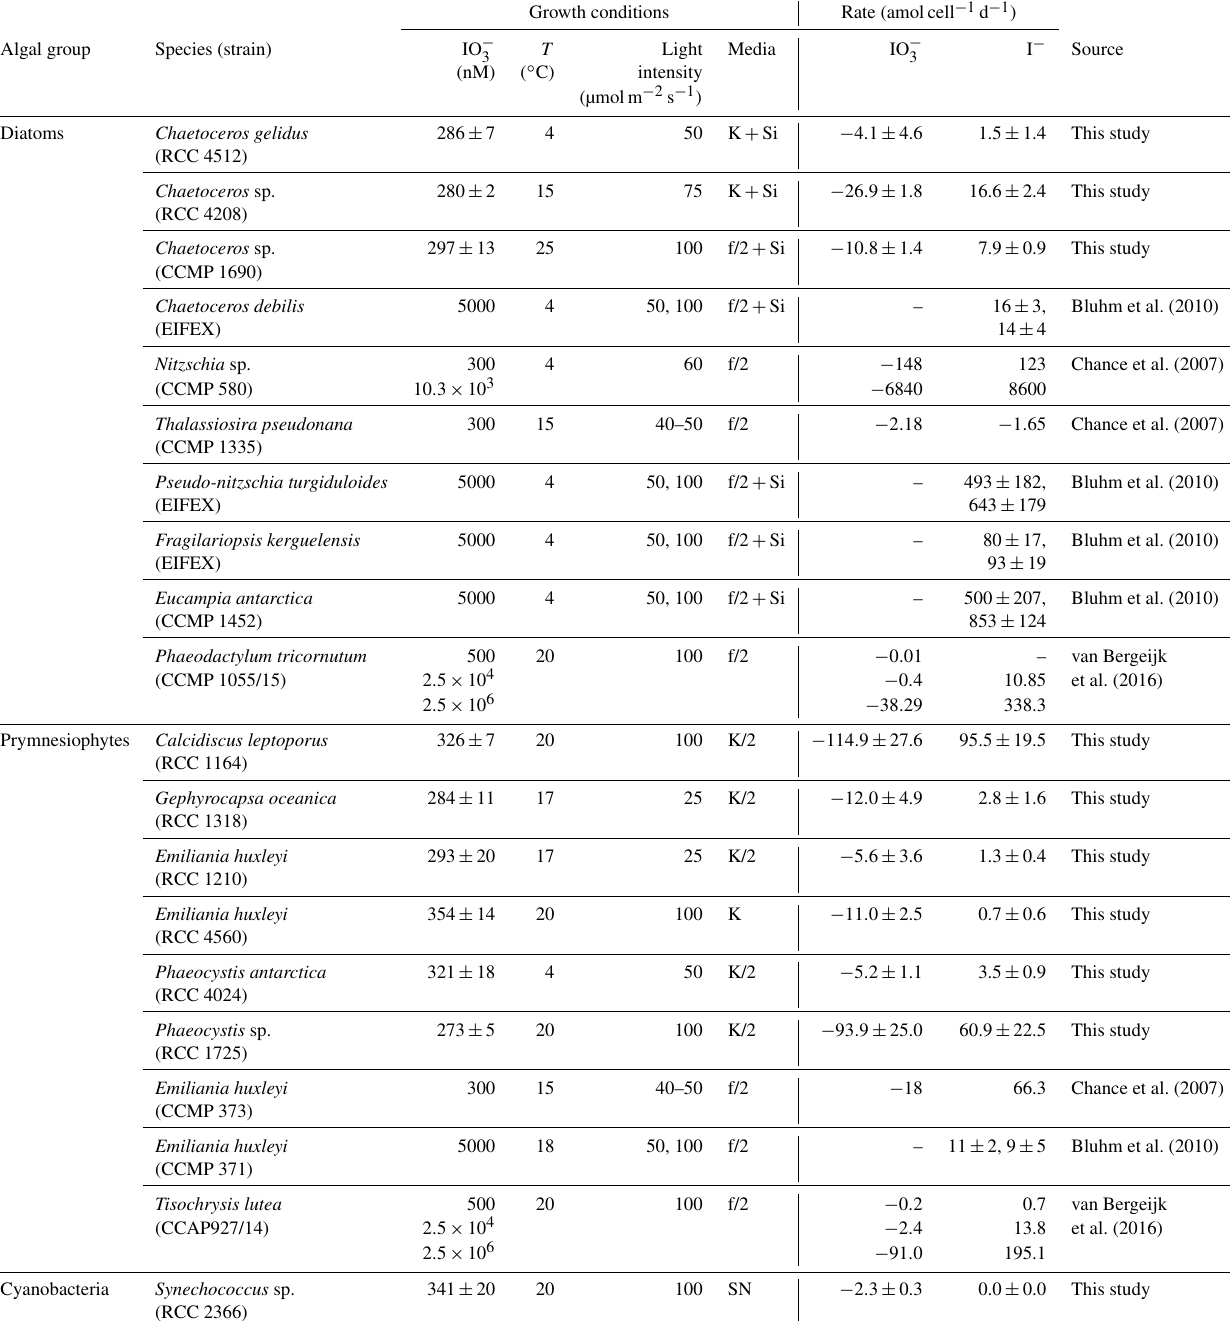
Table 1. Logarithmic-phase cell-normalised rate of iodate removal and iodide production in a range of marine phytoplankton species investi- gated in this study and previous studies. Experimental conditions are also listed for comparison. Errors for this study are standard deviations of three replicate